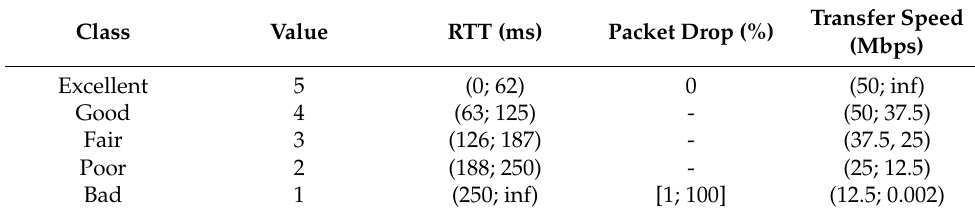
Table 2. Definition of rating classes for needs of the MOS